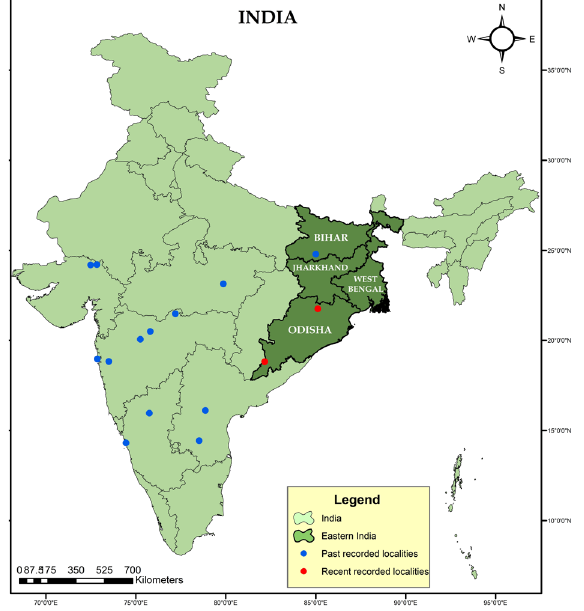
Figure 1. Map showing detailed recorded localities of Hipposideros galeritus in India